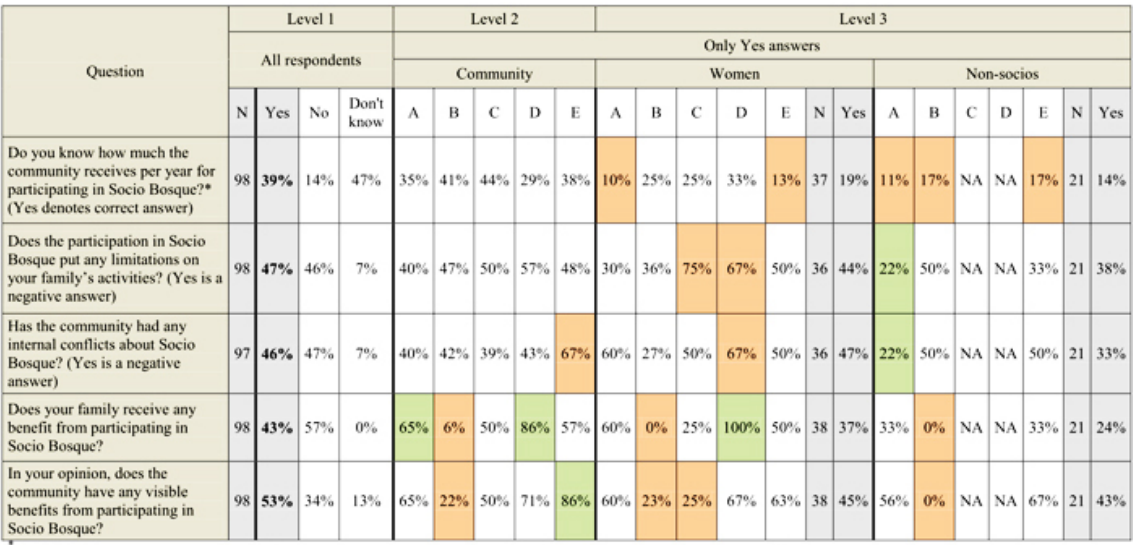
Fig. 5 . Interview questions and answers related to equitable, nondiscriminatory, and transparent benefit sharing and distribution for all respondents (Level 1), by individual communities (Level 2), and for women and non- socios within each community (Level 3). The percentages are relative to the number of respondents in that group (i.e., total respondents in each community for Level 2, or total women or non-socios in each community for Level 3). Means across all communities for the total number of women and non-socios are shown in gray columns. The percentages for each group are highlighted in green when ‡ 20% higher than the global mean (Level 1), or yellow when ‡ 20% lower than the global mean. Bold font indicates the aggregated “Yes” answers on which the disaggregated answers for each community are based. NA = not